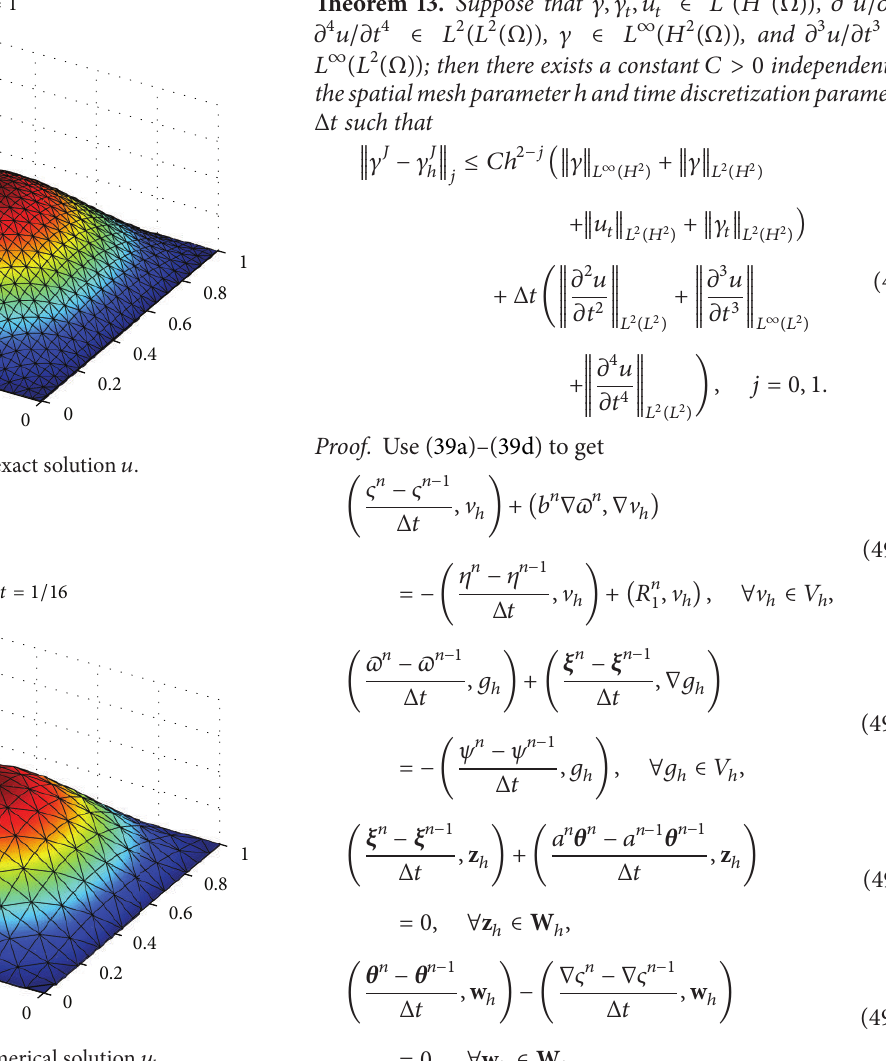
Figure 2: Surface for numerical solution 𝑢 ℎ